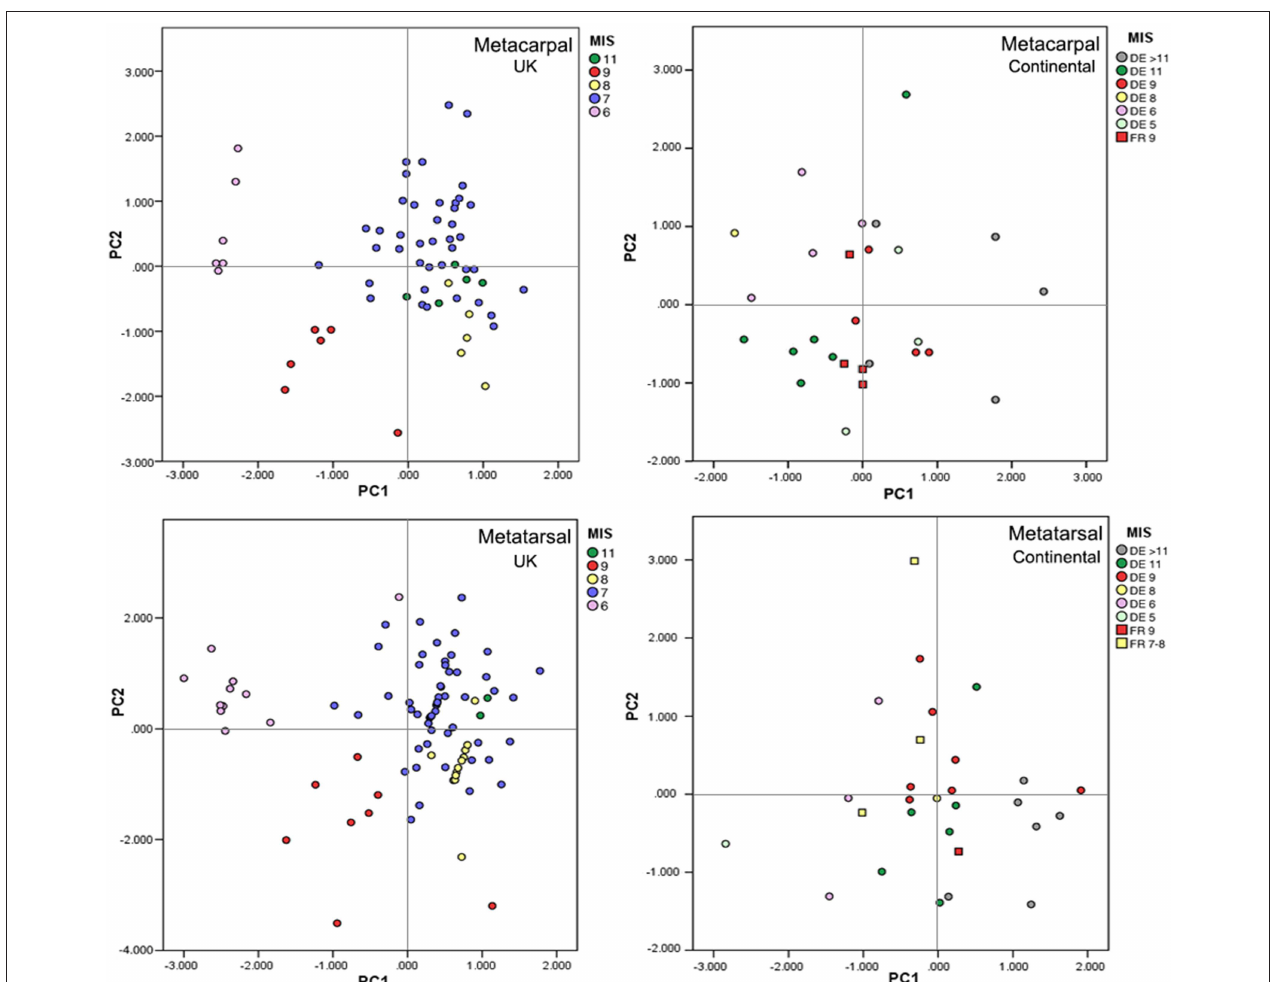
FIGURE 7 | Principal component analysis of complete caballoid equid metacarpals and metatarsals from late Middle Pleistocene British sites and continental Europe; PC2 plotted against PC1 (modified from van Asperen, 2010, Copyright © 2010 Elsevier BV, with permission from Elsevier); PC1 generally relates to overall size, while PC2 tends to reflect robusticity. Supplementary data available in van Asperen